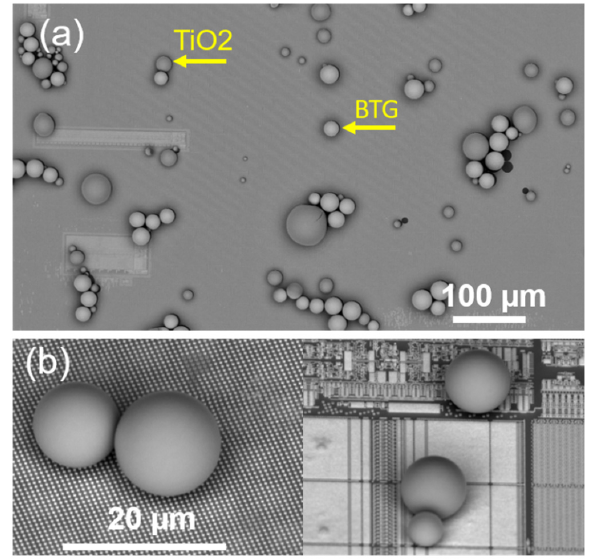
Figure 3. ( a ) SEM image of meta-TiO 2 (grey color) and BTG microspheres (bright) as indicated by arrows, separately. ( b ) A combined image of meta-TiO 2 microspheres located on different nanofeatures to demonstrate their full-sphere shapes.